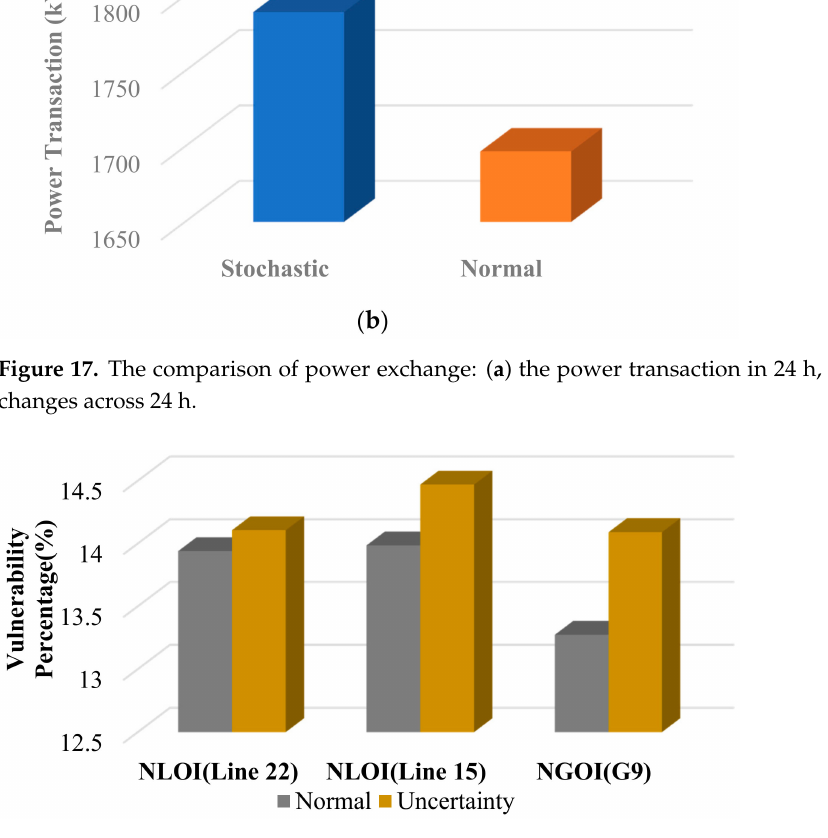
Figure 18. The comparison of vulnerability indices.